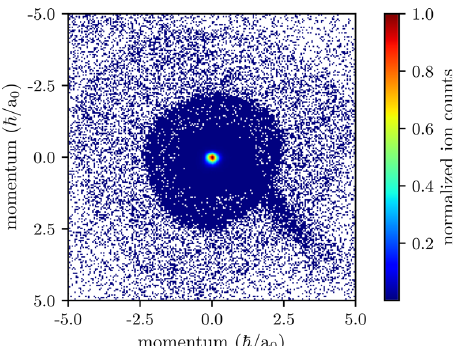
Fig. 3 Detector image resulting from the decay of 25P-ULRMs. The center of the plot consists of ions with vanishing transverse momentum, stemming mainly from photoionized ULRMs that have not undergone a state- changing collision. The two concentric circles at momenta 2.5 and 5.0 ℏ / a 0 are due to the decay into the 22Hy and 21Hy hydrogenic manifolds. The feature in the lower right quadrant is due to technical issues of the detection unit. Sum of 10 7 experimental runs, normalized to the maximum number of ion counts.